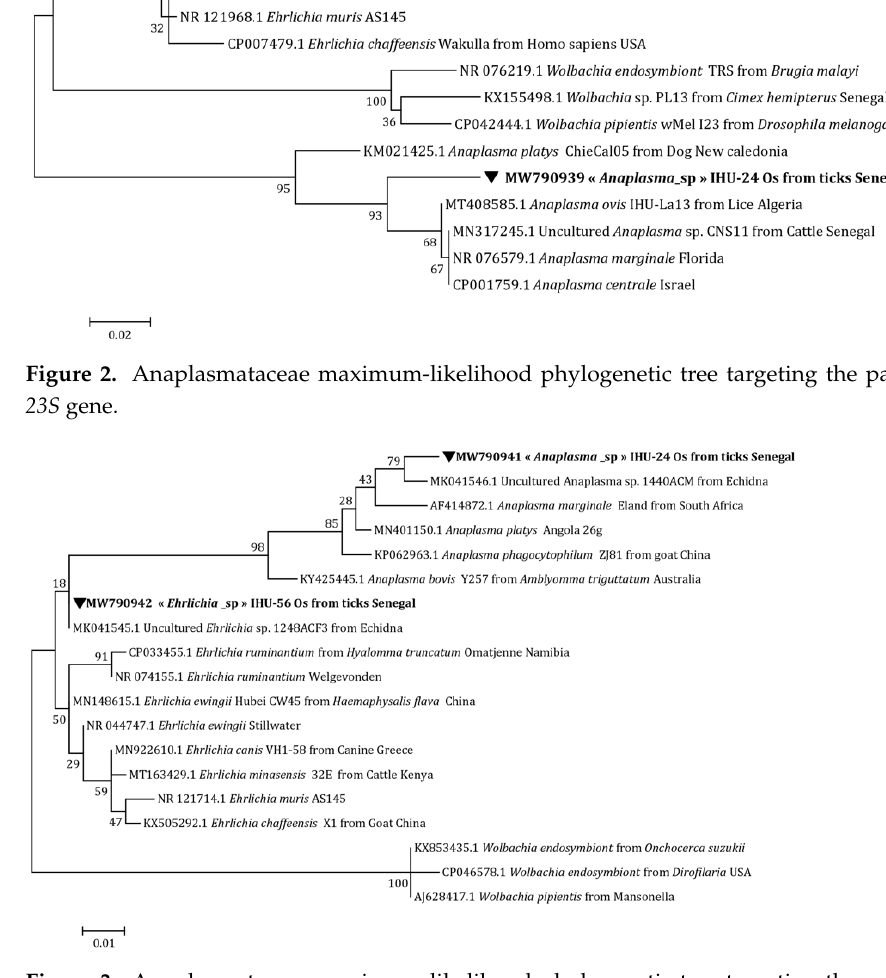
Figure 3. Anaplasmataceae maximum-likelihood phylogenetic tree targeting the partial 345 bp 16S gene.